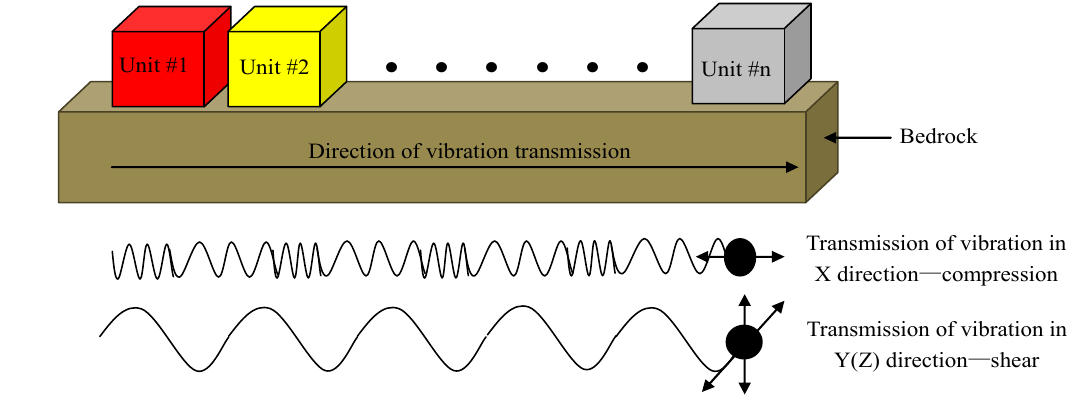
Figure 13. Transmission of vibration in different directions.